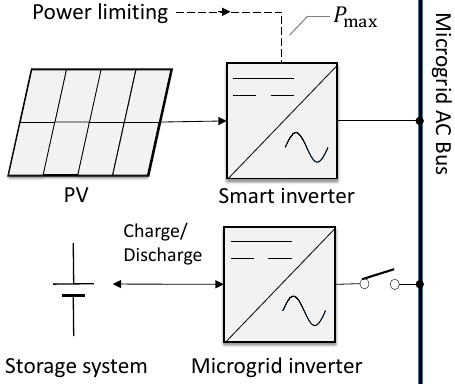
Figure 27. Simulation block diagram.